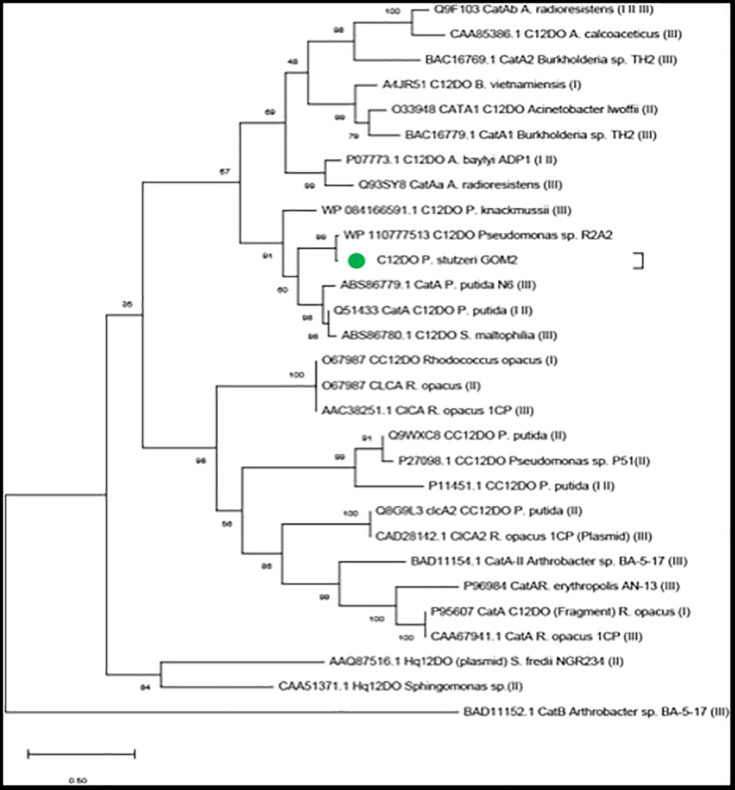
Evolutionary analyses. The green circle denotes the sequence of P. stutzeri GOM2. In the parentheses the reference is indicated where the protein sequence was obtained: (I) Nazmi et al. (2019), (II) Caglio et al. (2009), and (III) Guzik et al. (2013).